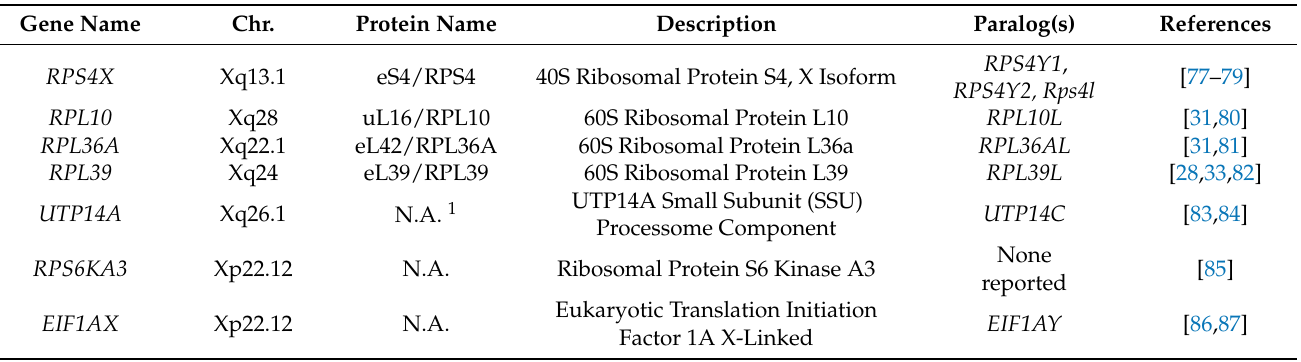
Table 2. X-linked Genes that Constitute or Influence Ribosome Structures in Male Germ